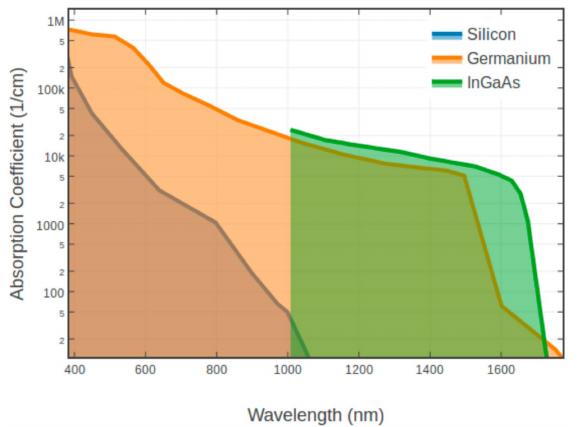
Figure 30. Comparison absorption characteristics of Si, Ge, and InGaAs. Reproduced from [86], open access by White Rose eTheses Online,